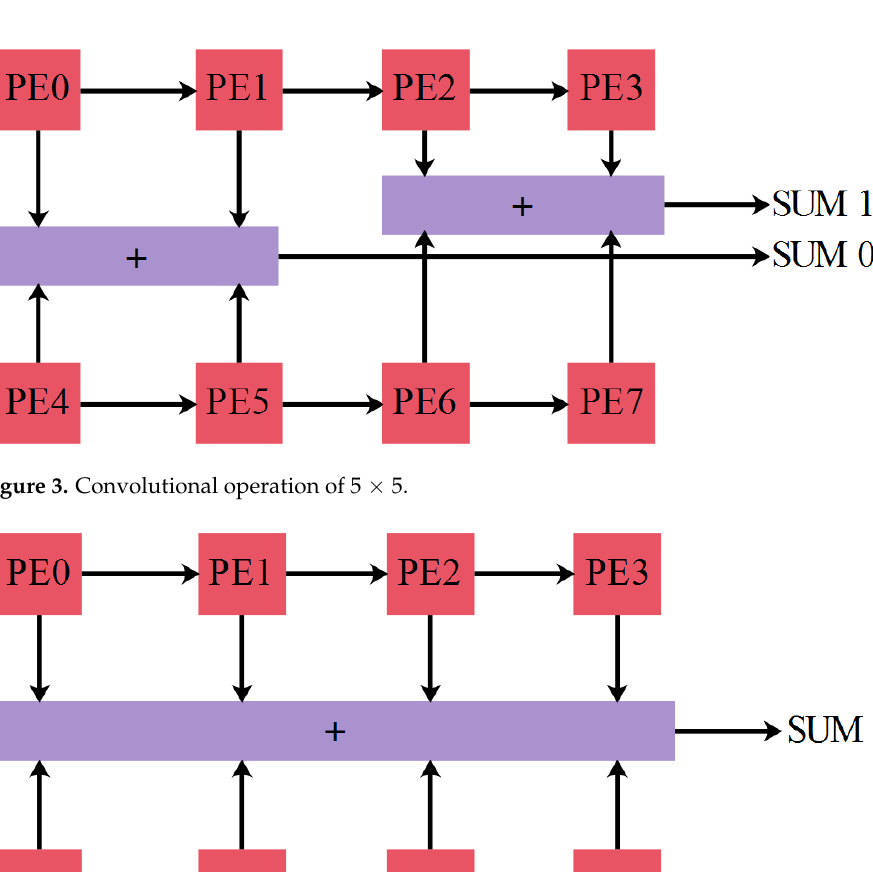
Figure 4. Convolutional operation of 7 × 7. Table 1. P eak multiplier utilization for various kernel sizes.